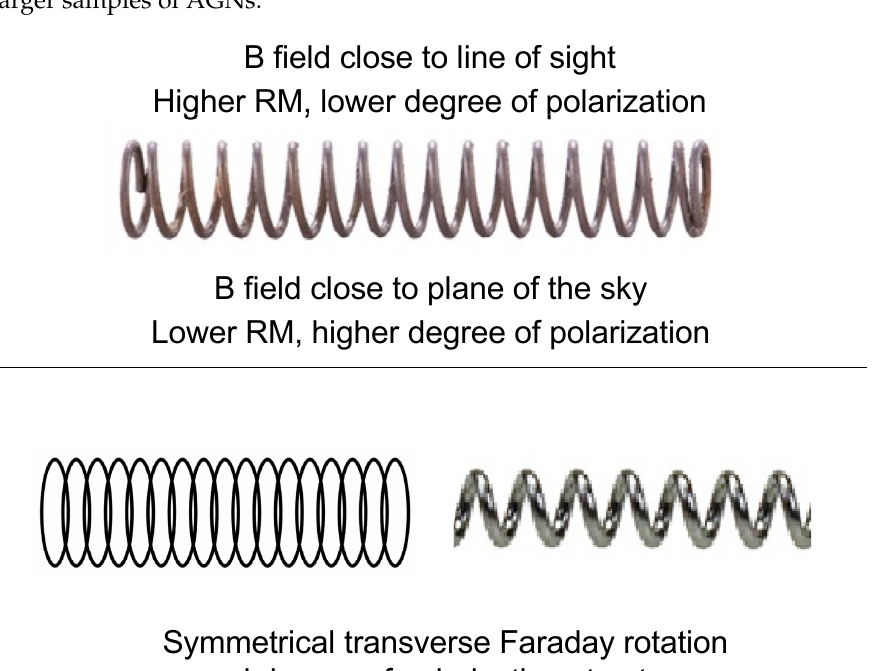
Figure 3. Schematic illustration of the origin of the asymmetric polarization and RM patterns expected for a helical B field observed at an angle other than 90 ◦ to the jet axis ( top ) and the symmetric polarization and RM patterns expected for a purely toroidal field viewed at any angle or a helical field viewed at precisely 90 ◦ to the jet axis ( bottom